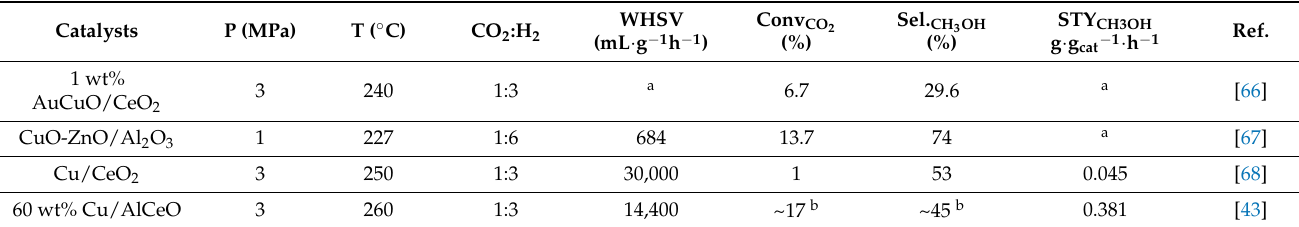
Table 2. Summarized catalysts for CO 2 hydrogenation to